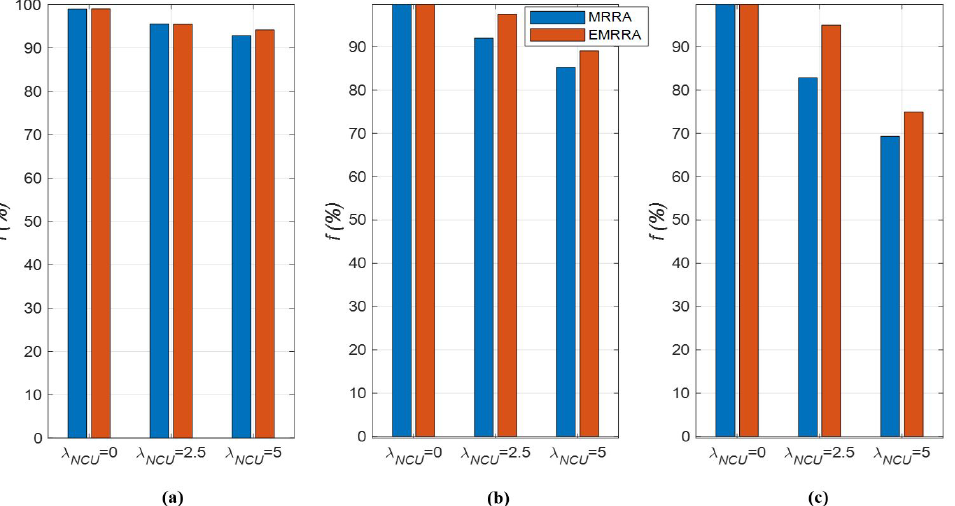
Figure 11. The fairness of EMRRA and MRRA with respect to λ NCU , K ,and N CU : ( a ) N CU = 10, K = 50; ( b ) N CU = 25, K = 50; ( c ) N CU = 50, K =